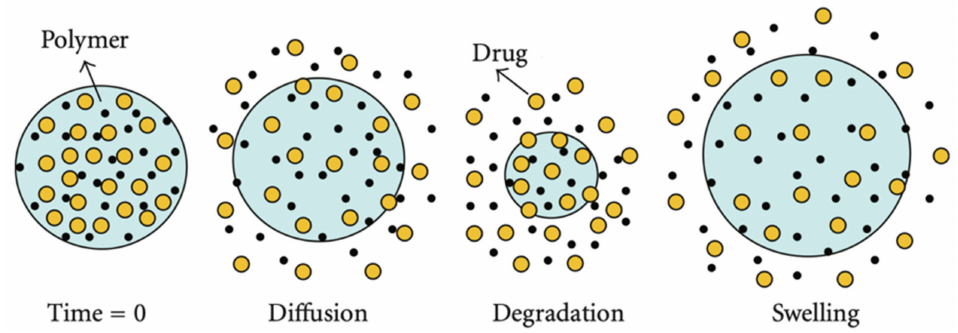
Figure 3. Drug release mechanisms of PLA microspheres